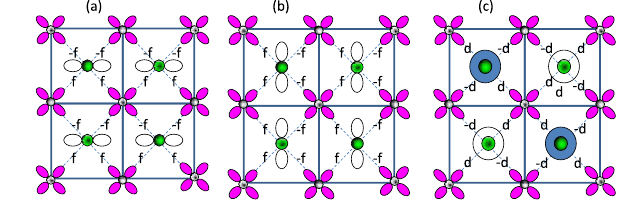
− p couplings. Here, f ¼ j t xy